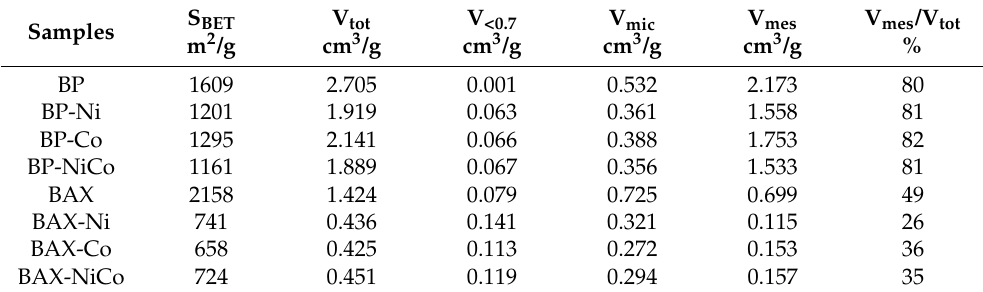
Figure 9. Atomic % of the elements on the surface (as numbers on the right of each segment)) and the contributions of various bonds from the deconvolution of C 1s, O 1s, N 1s and S 2p core energy level spectra (in % contribution on x axes ( from 1-100 %) for the BP series ( A ) and BAX series ( B )). Table 1. The parameters of pore